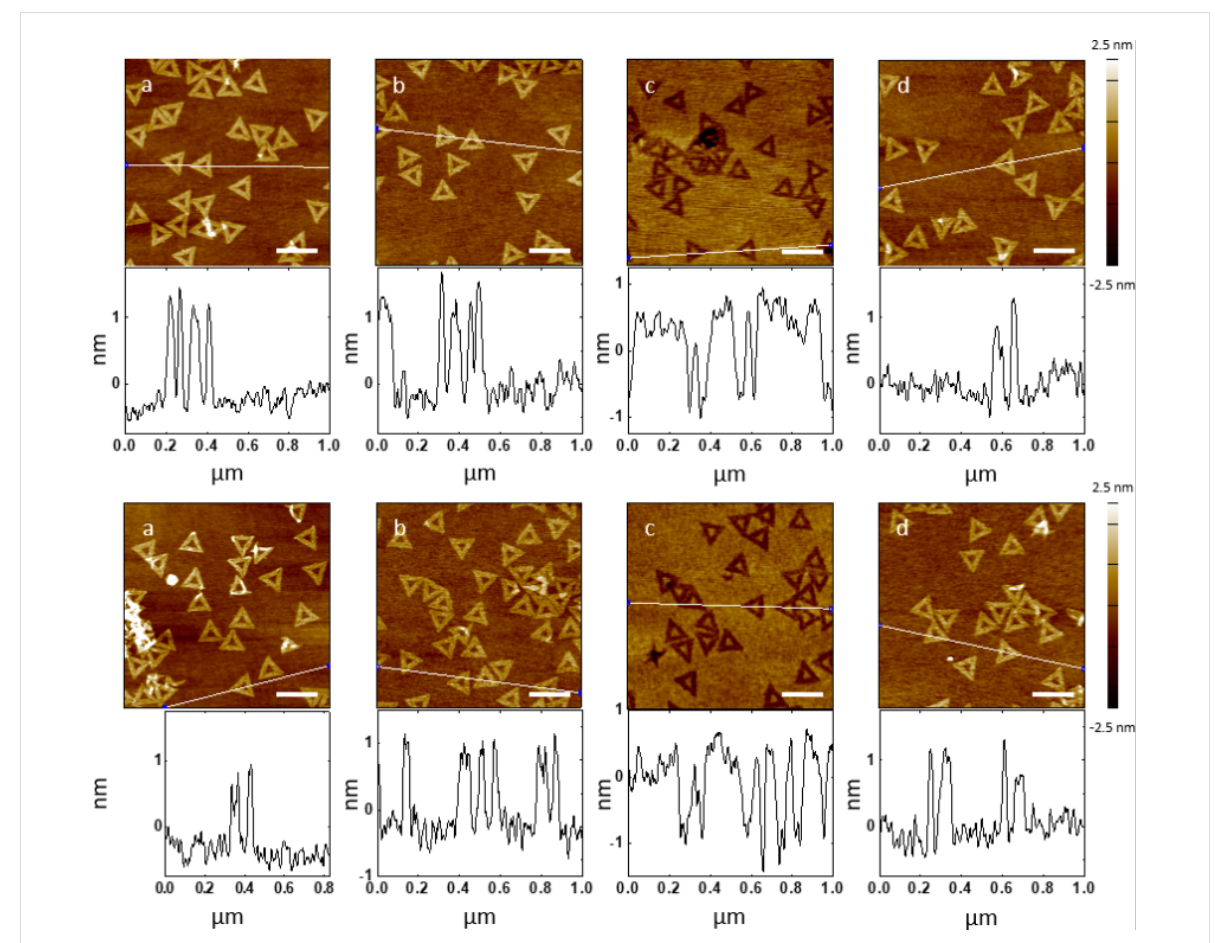
Figure 6: Comparison of features on DNA origami triangle master templates with a ca. 2 nm or a ca. 5 nm thick Al 2 O 3 layer and PLLA stamps. AFM height images and corresponding cross-sectional analysis of origami triangles after (a) deposited on silicon wafers, (b) 20 cycles (top) or 50 cycles (bottom) of ALD of Al 2 O 3 , and (d) pattern transfer to PLLA stamps, and (c) their negative replicas on the PLLA stamps. White lines on the AFM images indicate where the cross-sections were determined. Scale bars represent 200 nm.